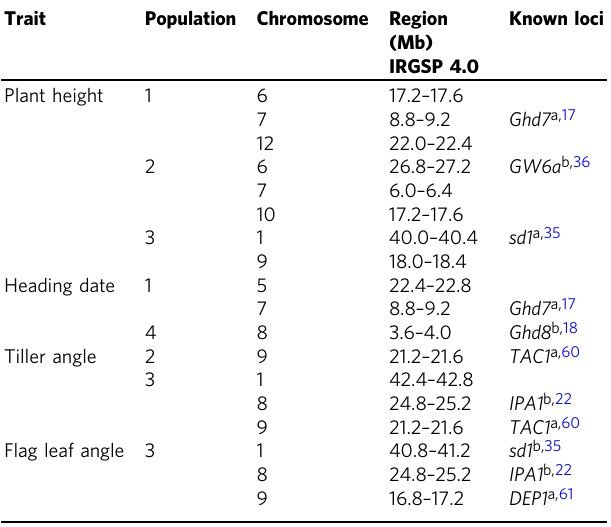
Table 1 Identi fi ed genomic intervals for four agronomic traits Trait Population Chromosome Region